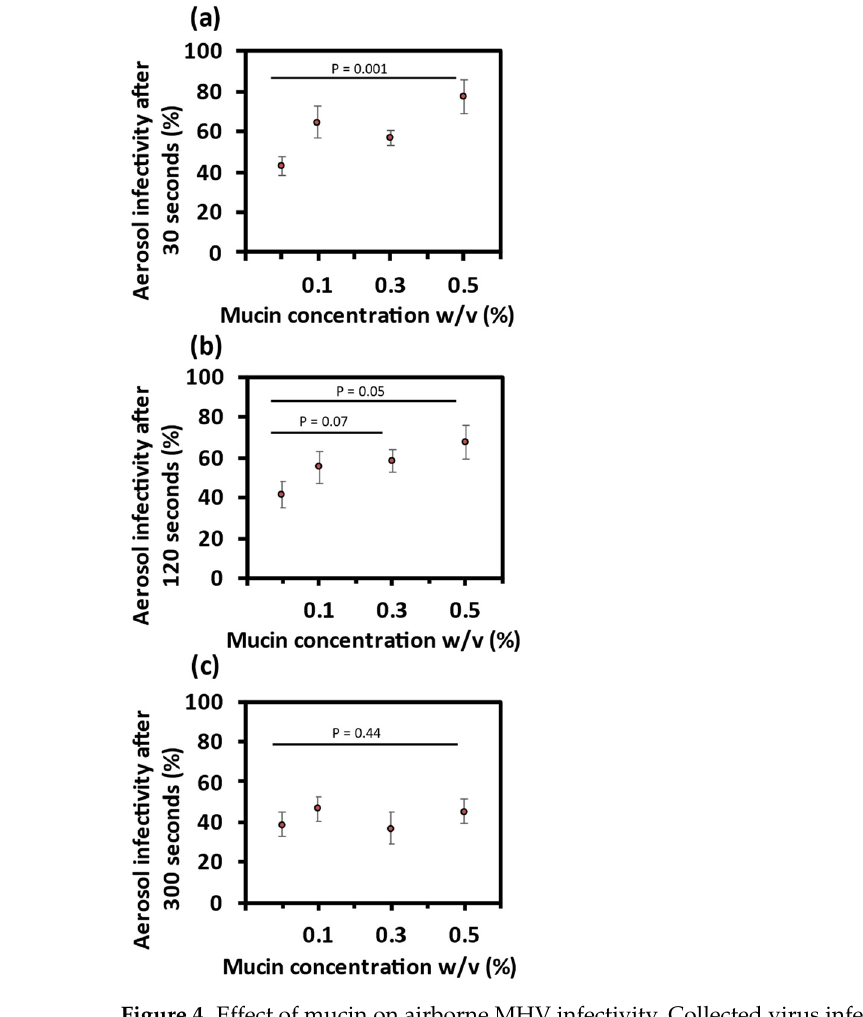
Figure 4. Effect of mucin on airborne MHV infectivity. Collected virus infectivity after levitation at 40% RH with increasing concentrations of mucin. ( a ) 30 s. ( b ) 120 s. ( c ) 300 s.